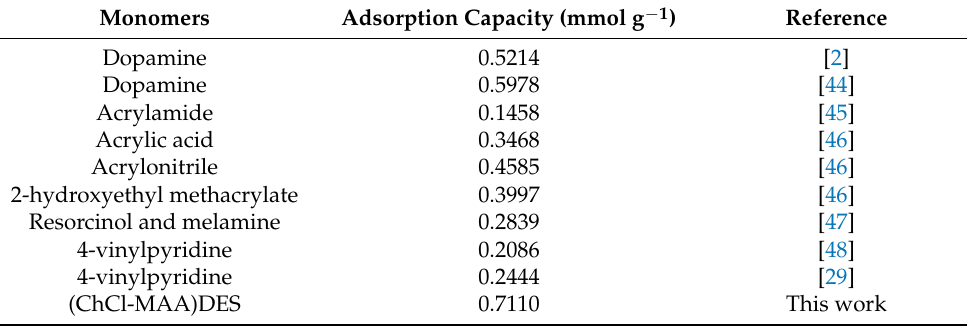
Table 4. Comparison adsorption capacity of GA-enriched MIPs reported in the